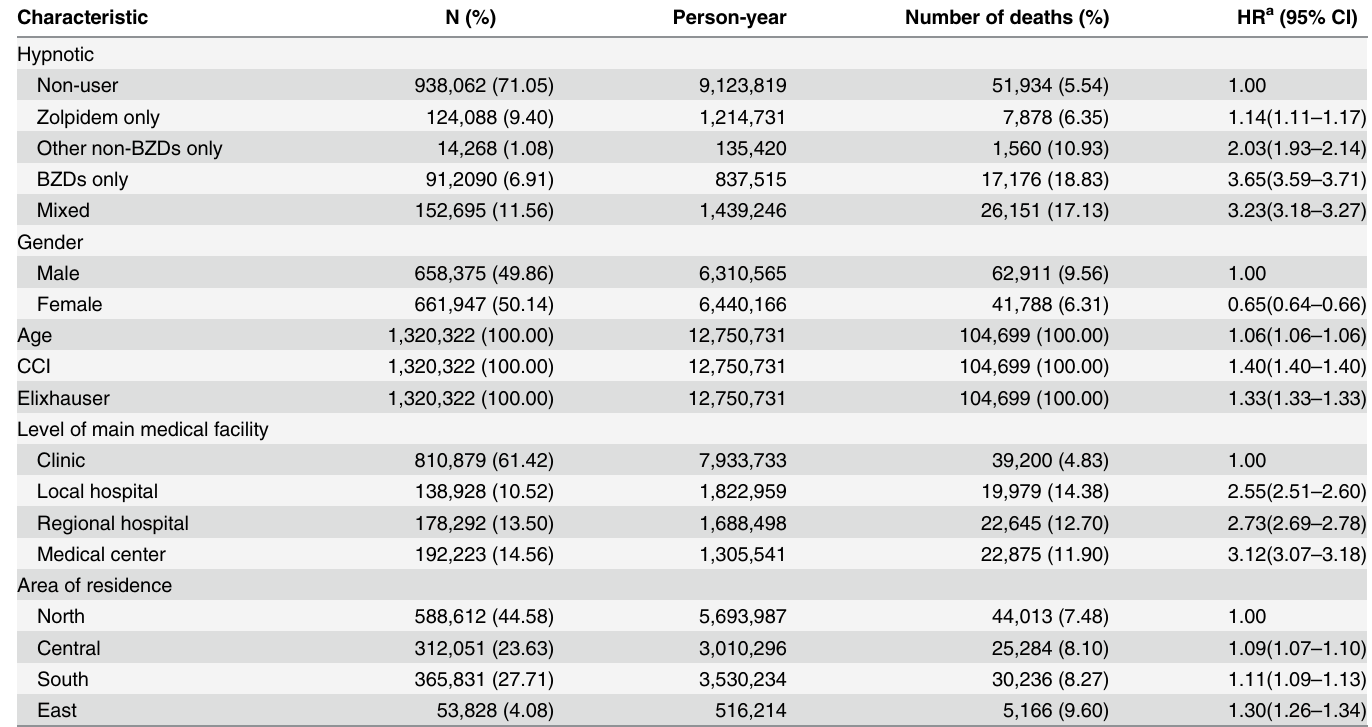
Mixed indicates those who used at least two types of hypnotics: zolpidem and other non-BZDs, or non-BZDs and BZDs. BZDs = benzodiazepines; CCI = Charlson comorbidity index; HR = hazard ratio; CI = con fi dence interval. Standard errors of age, CCI, and Elixhauser were extremely small; consequently the 95% CI of these variables was approximately equal to the hazard ratio. a HR has not been adjusted for other